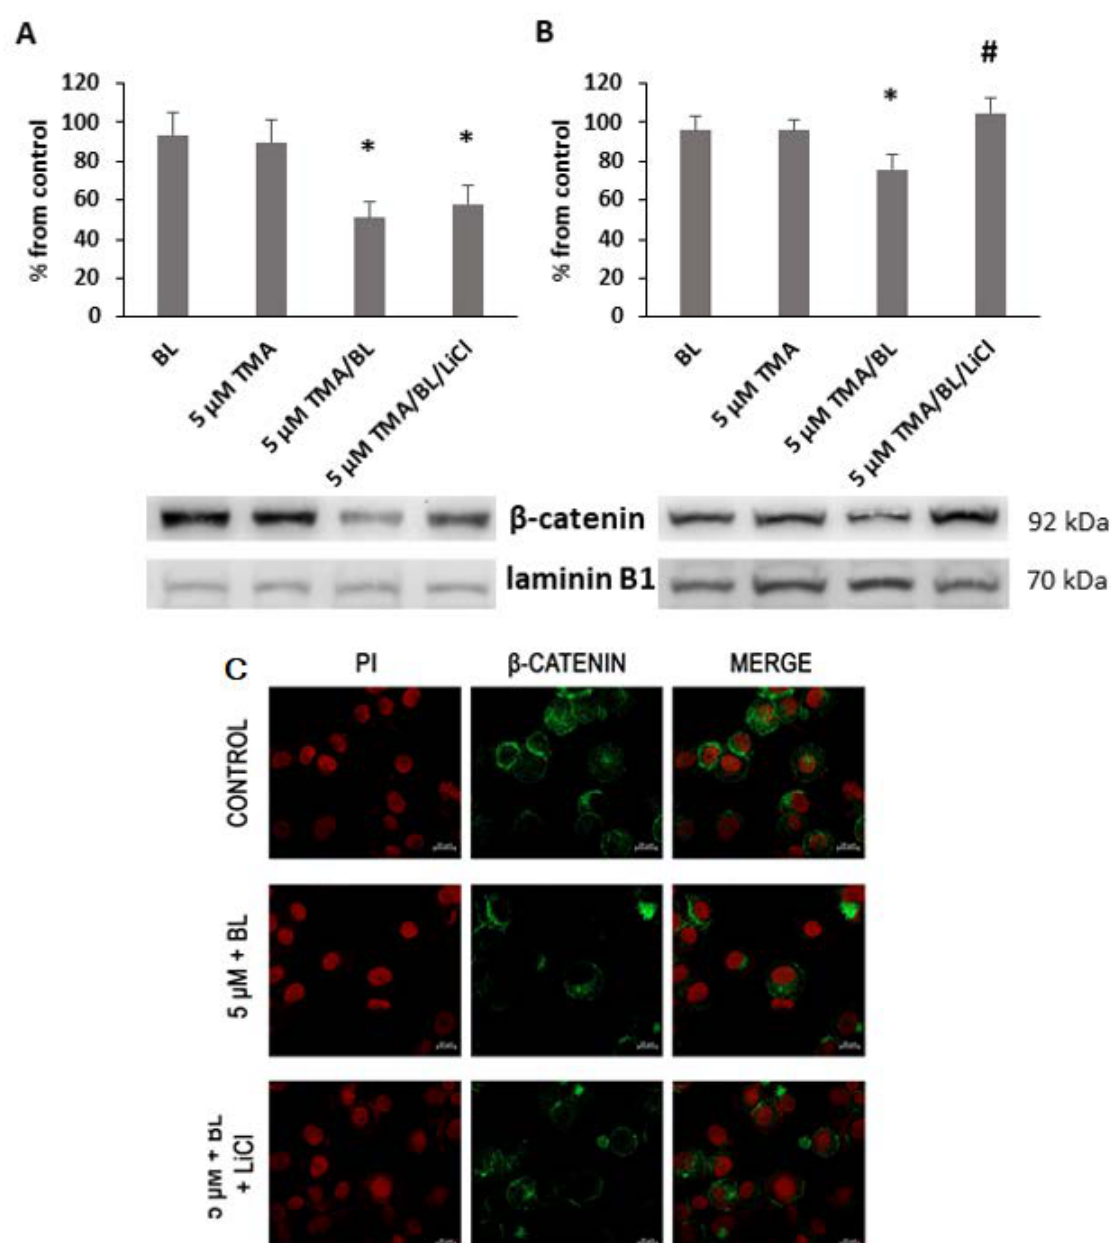
Figure 4. Nuclear expression of β -catenin. At 24 ( A ) and 48 ( B , C ) h after the treatment with TMA, BL (2 J/cm 2 ), and 1-mM LiCl, the β -catenin expression was verified by Western blotting (WB) ( A , B ) and immunofluorescence ( C ). Quantification of the expression levels was carried out by a densitometric analysis using ImageJ software ( A , B ). Data were reported as percentages from the control cultures. * = p < 0.05 vs. control cultures and # = p < 0.05 vs. cultures treated with TMA/BL, Student’s t -test. ( c ) Nuclei and β -catenin-positive areas are in red and green fluorescence, respectively (bar: 20 µ